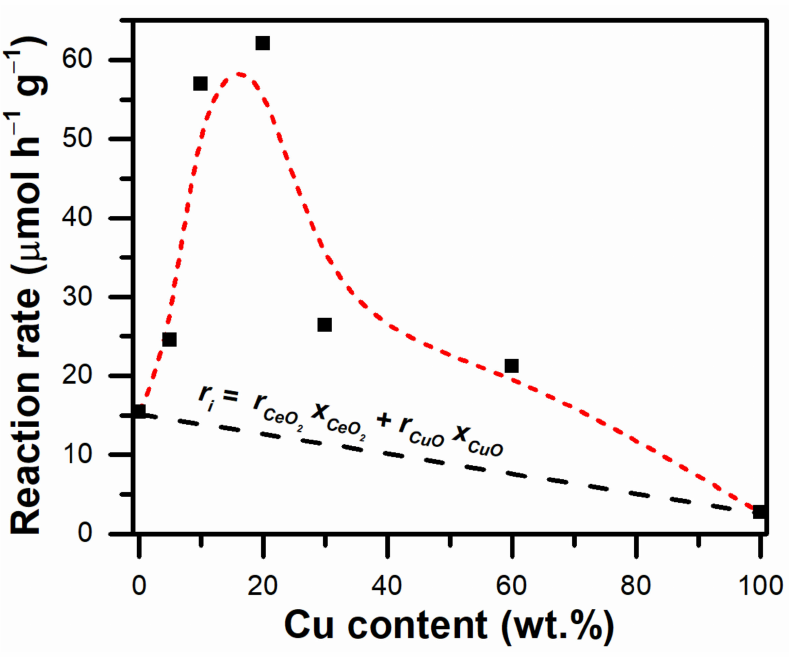
Figure 13. Ethene catalytic oxidation reaction rate behavior as a function of the Cu loading in the prepared